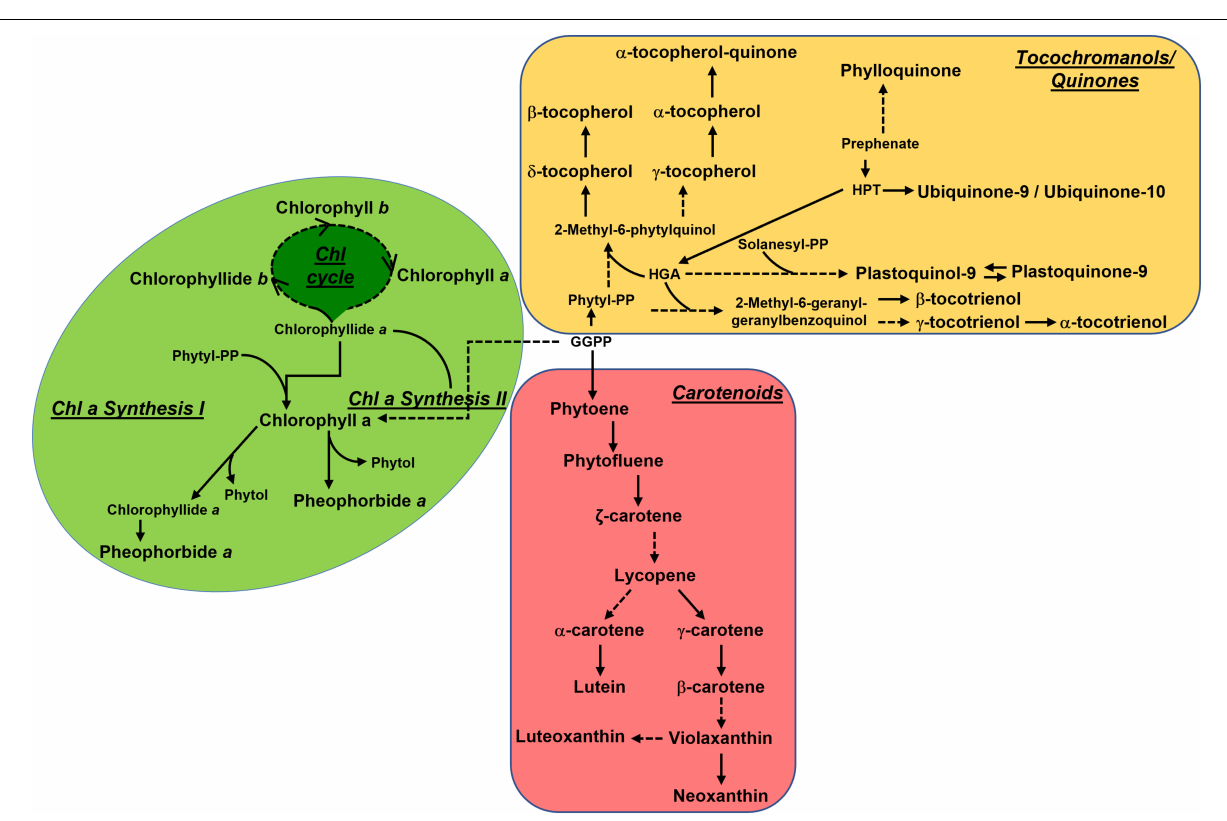
FIGURE 7 | Overview of the main isoprenoid biosynthetic pathways. Metabolic relationships between the main isoprenoid classes (chlorophylls, carotenoids, and tocochromanols/quinones) referred to in this study. The metabolism of carotenoids, chlorophylls, and tocochromanols occurs in the plastid, while quinones are